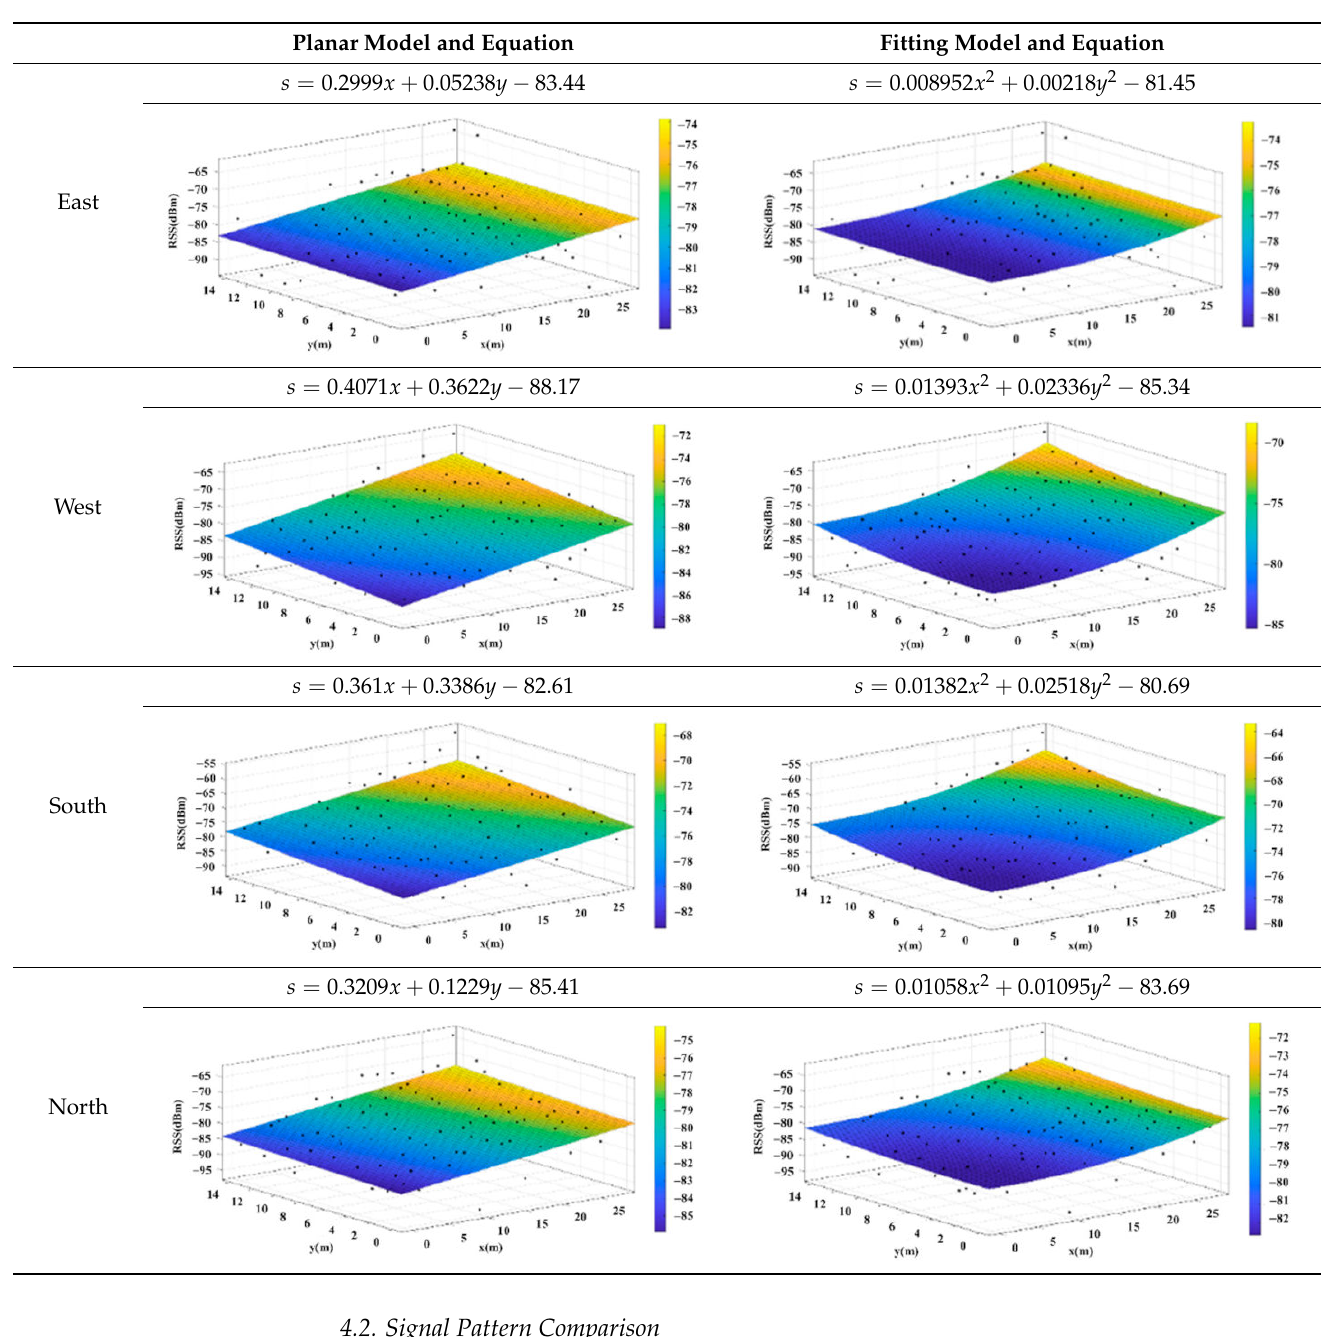
Table 7. Models and Equations Generated from the Four Directions in the Experimental Environment for Base Station